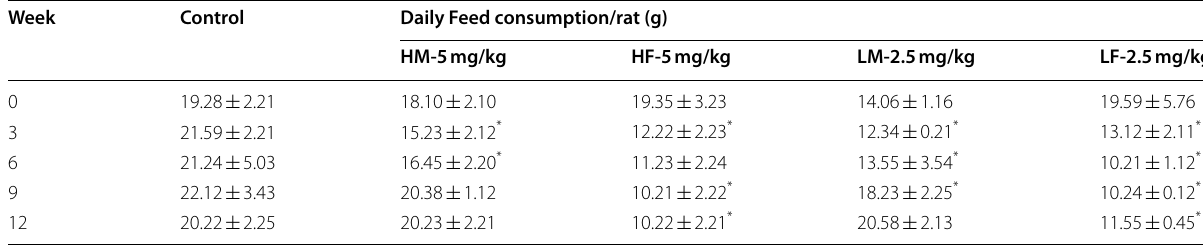
Table 1 Average daily feed consumption per rat in the various groups treated for 3 months with Mystomate4 ® compared with control treated with the